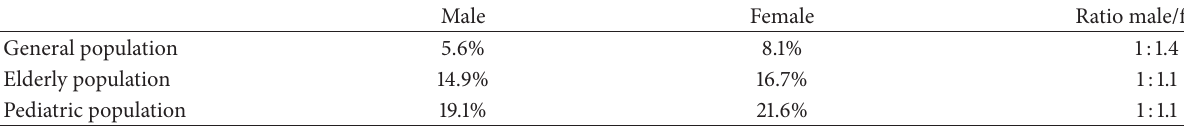
Table 4: Gender differences in the prevalence of constipation.